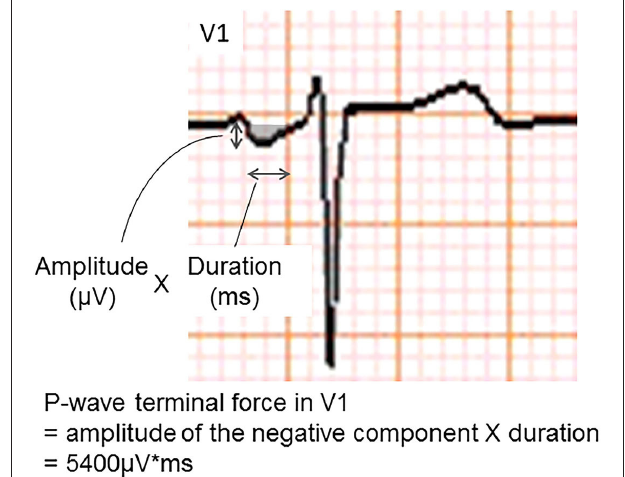
FIGURE 2 | An example of abnormal P -wave terminal force in lead V1. The P -wave terminal force in lead V1 was calculated as multiplying the amplitude and duration of the terminal negative part of the P -wave in lead